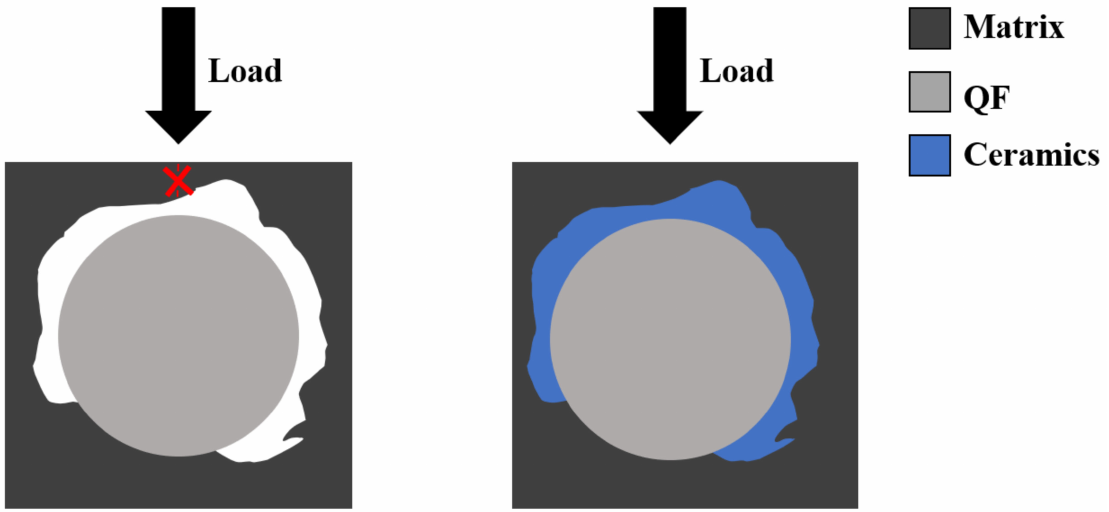
Figure 6. Failure mechanism of EP/QF ceramifiable composites.